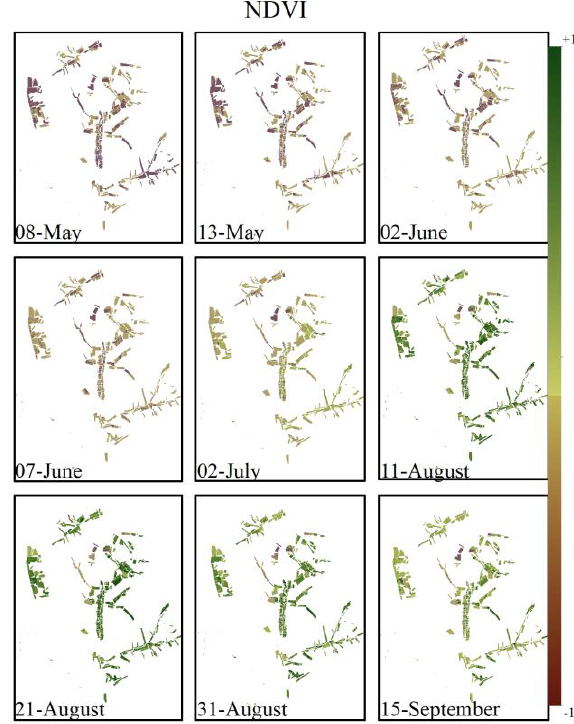
Figure 2. Spatial distribution of NDVI in Bornuur soum of Tuv province using Sentinel-2 with crop growing season of 2019.